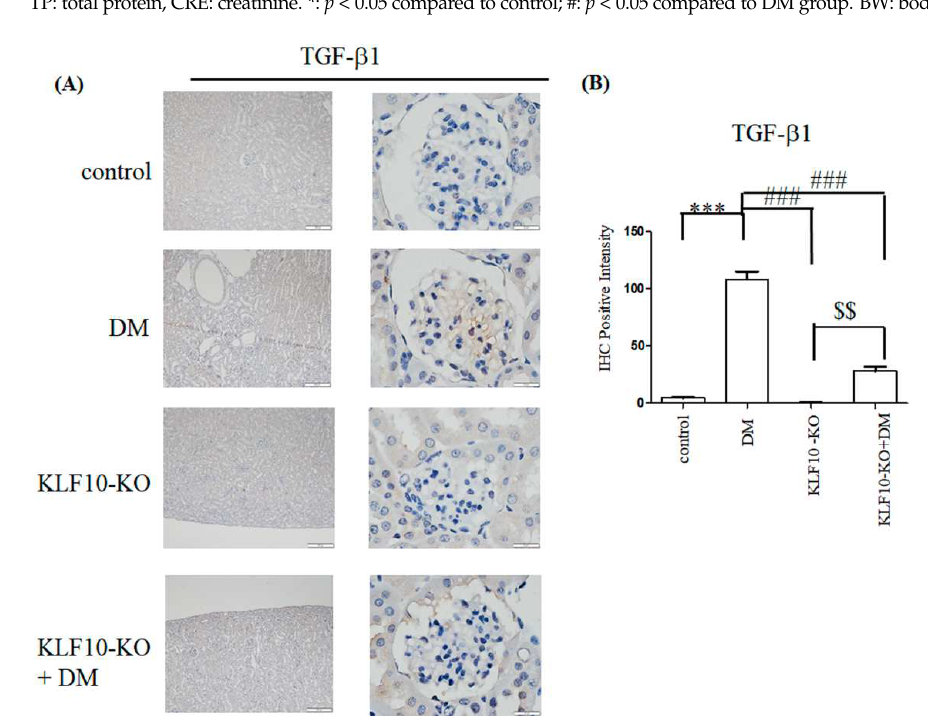
Figure 1. Decreased expression of TGF- β 1 in KLF10 knockout (KLF10-KO) in diabetic (DM) mice. ( A ) Immunostaining or ( B ) RT-PCR analysis of kidney glomerular mesangium sections derived from control or KLF10-KO mice with or without diabetes (DM). The sections were subjected to immunostaining with TGF- β 1 primary antibody. Left panel: magnification of 100 × , right panel: magnification of 1000 × . ( B ) Statistical analysis. Data are presented as means ± standard deviation from three different mice. ***: p < 0.001 compared with the control group. ###: p < 0.001 compared with the DM group. $$: p < 0.01 compared to KLF10-KO group. Scale bar: 200 µ M at 100 × and 20 µ M at 1000 ×